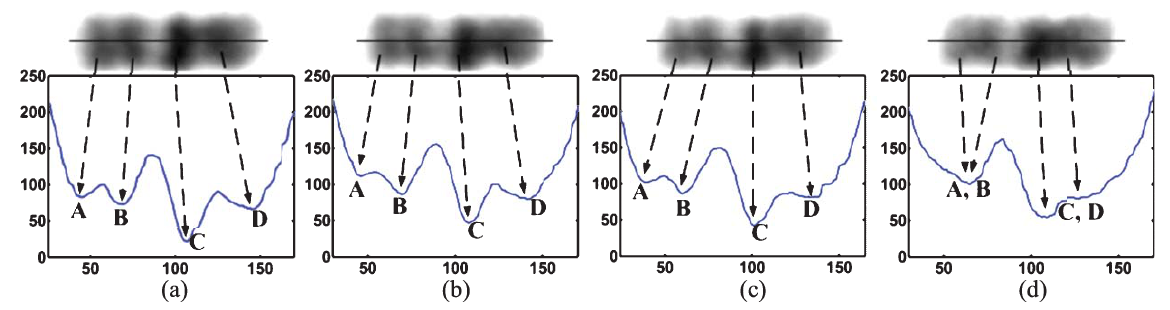
Fig. 10. The density profiles of a typical chromosome used to analyze the impact of the condenser on chromosome bands under 40 × objective and different value s : (a) s =0.6 (b) s =0.8 (c) s =1.0 (d) s =1.2; it is shown that bands A and B can be separated in (a), (b) and (c), but can’t in (d). Also, bands C and D in (d) have the decreased contrast compared with those in (a), (b) and (c).